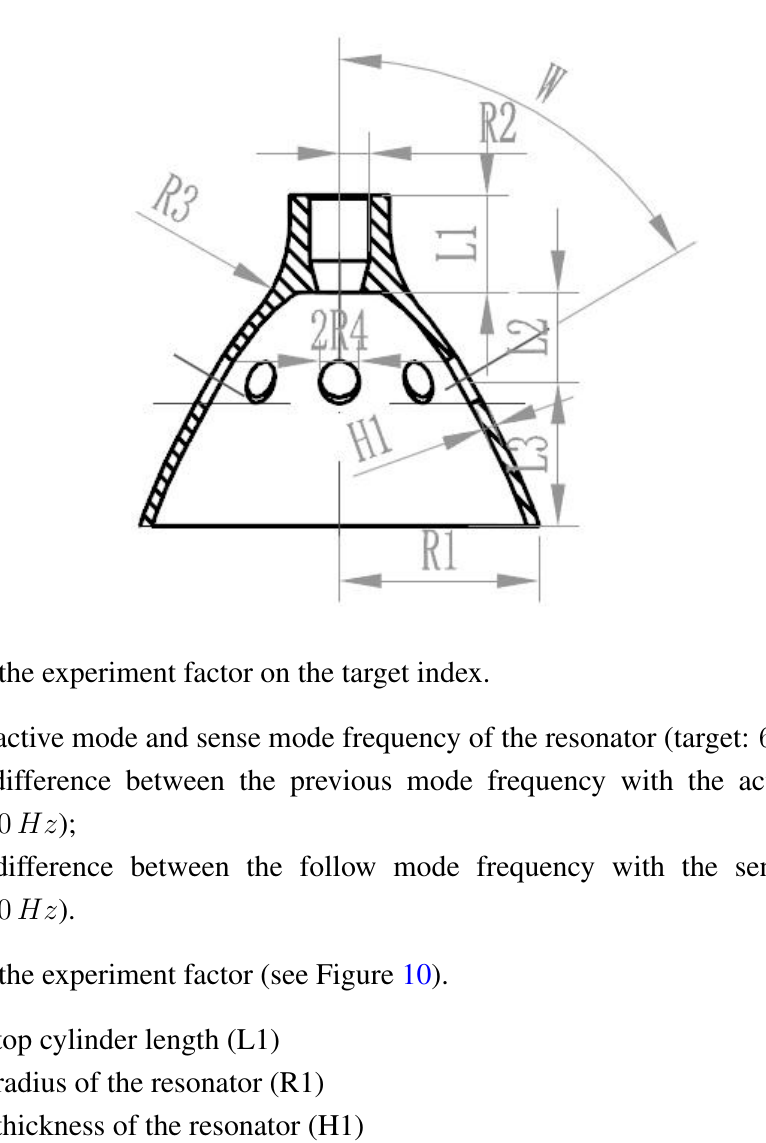
Figure 10. The schematic diagram of the resonator